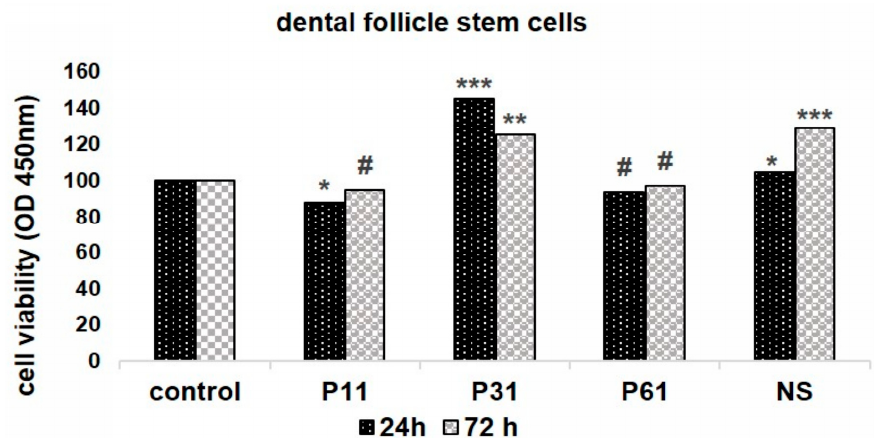
Figure 8. Cell viability of dental follicles on bleached cement samples exposure (lower panel) with G28 bleaching gel; each bar represents mean ± standard deviation (n = 3); # not significant, * p < 0.05; ** p < 0.01, *** p < 0.001, compared to untreated controls, (upper panel).